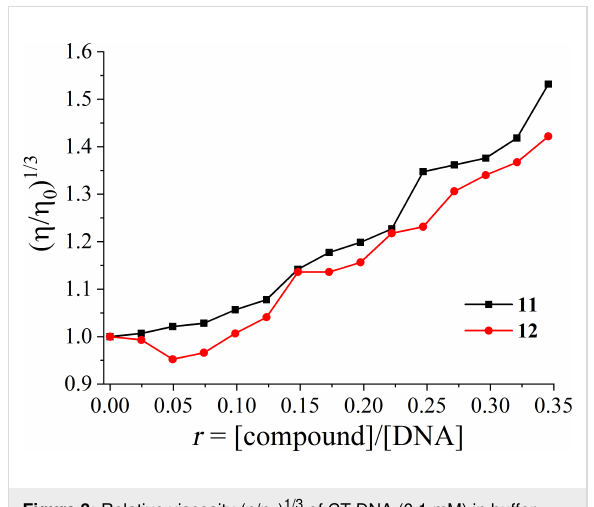
Figure 3: Relative viscosity ( η / η 0 ) 1/3 of CT DNA (0.1 mM) in buffer solution in the presence of compounds 11 and 12 at increasing amounts.